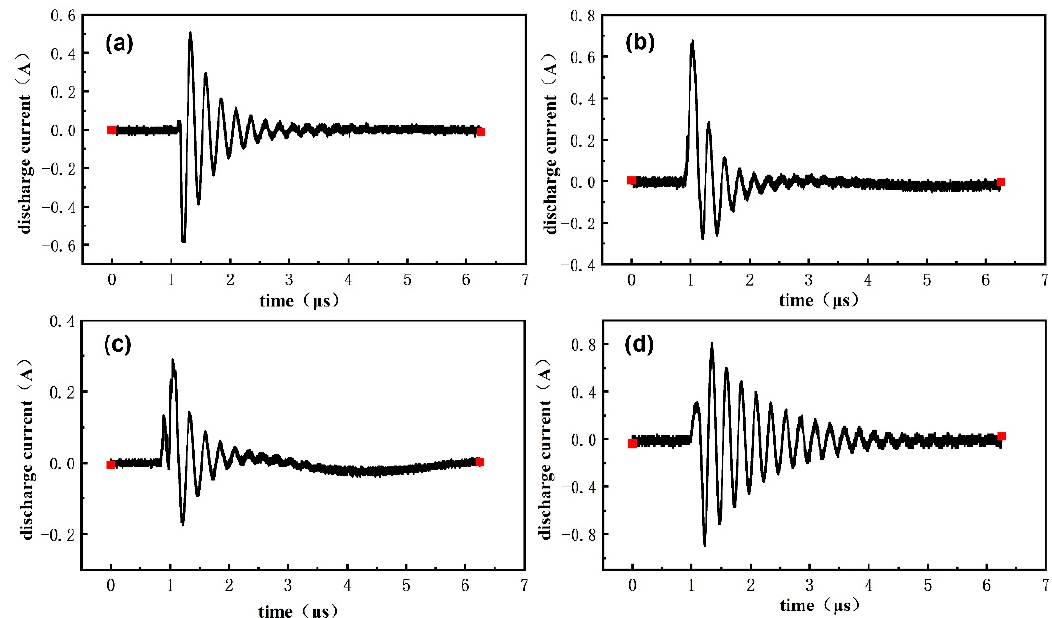
Figure 7. Discharge waveform of solar array irradiated by electron beam without external field. ( a ) Negative charge discharge of PI film on Al honeycomb substrate; ( b ) Positive charge discharge of solar cell on the Al honeycomb substrate; ( c ) Surface flashover discharge between the glass cover and PI film of solar cell; ( d ) Regarding the electrostatic discharge between the glass cover of solar cell and the Al honeycomb substrate and PI Film.